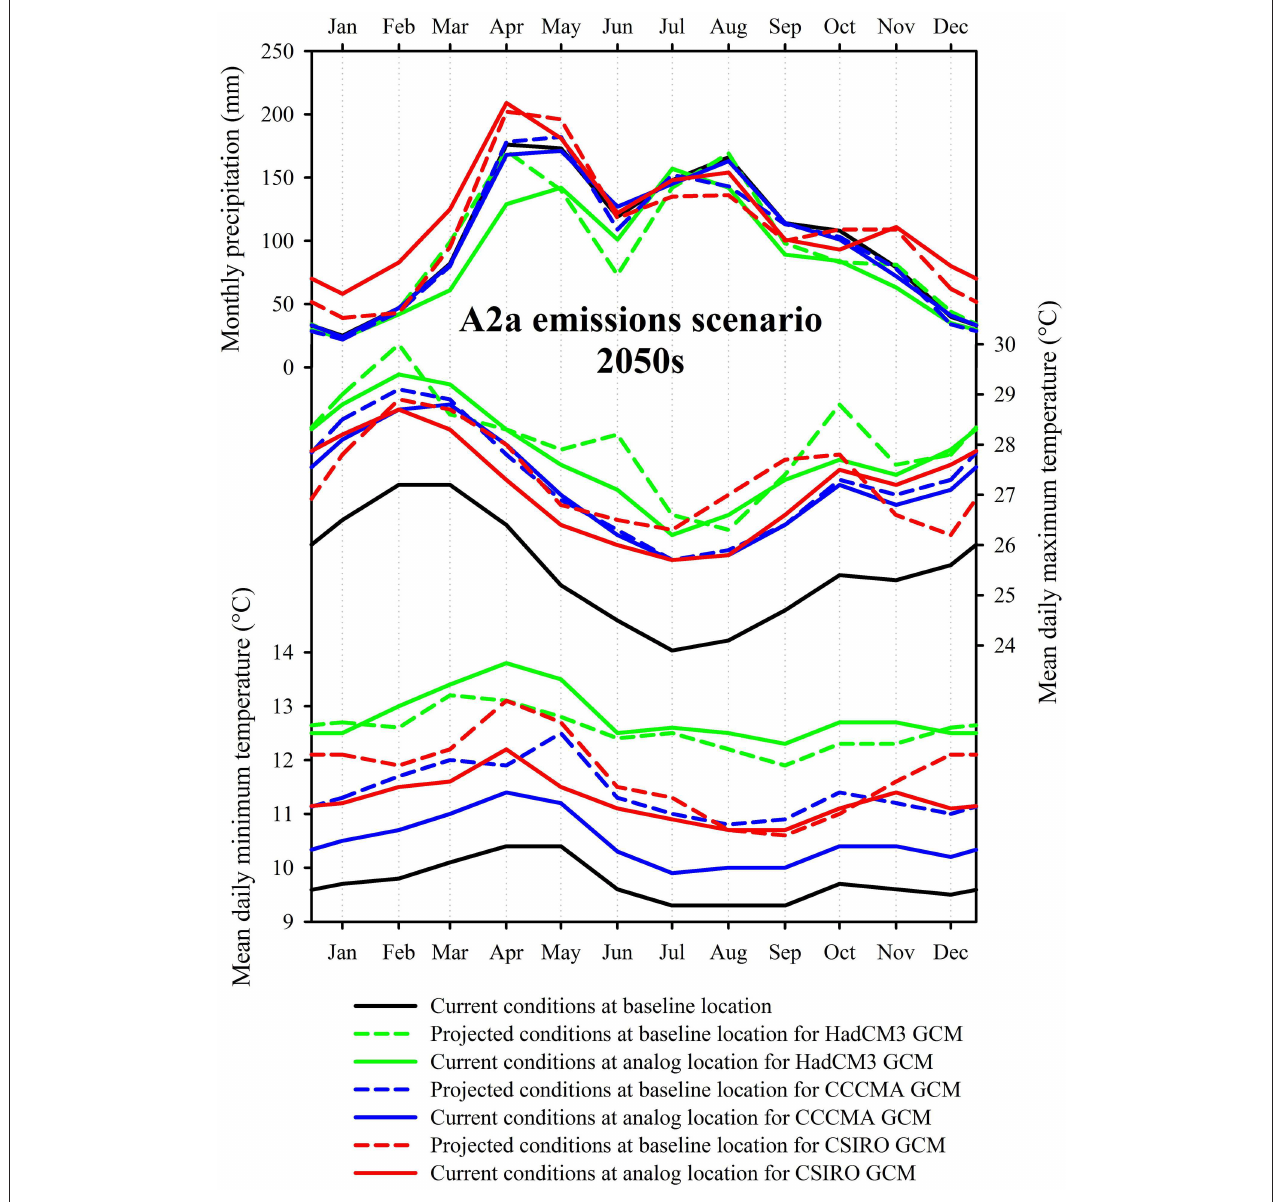
FIGURE 4 | Distributions of monthly precipitation, mean daily maximum, and minimum temperatures derived from the WorldClim and CCAFS databases. Data are shown for the current climate of the baseline location, projected climate at the baseline location, and current climate at analog locations corresponding to projected futures according to three climate models, for the A2a greenhouse gas emissions scenario and the 2050s projection